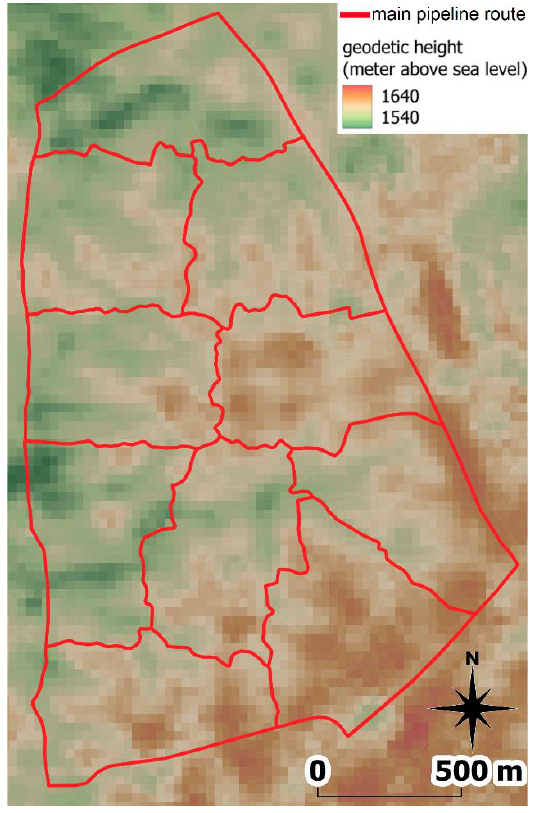
Figure 9. Final main pipeline route and DEM (DEM-data: [48]).